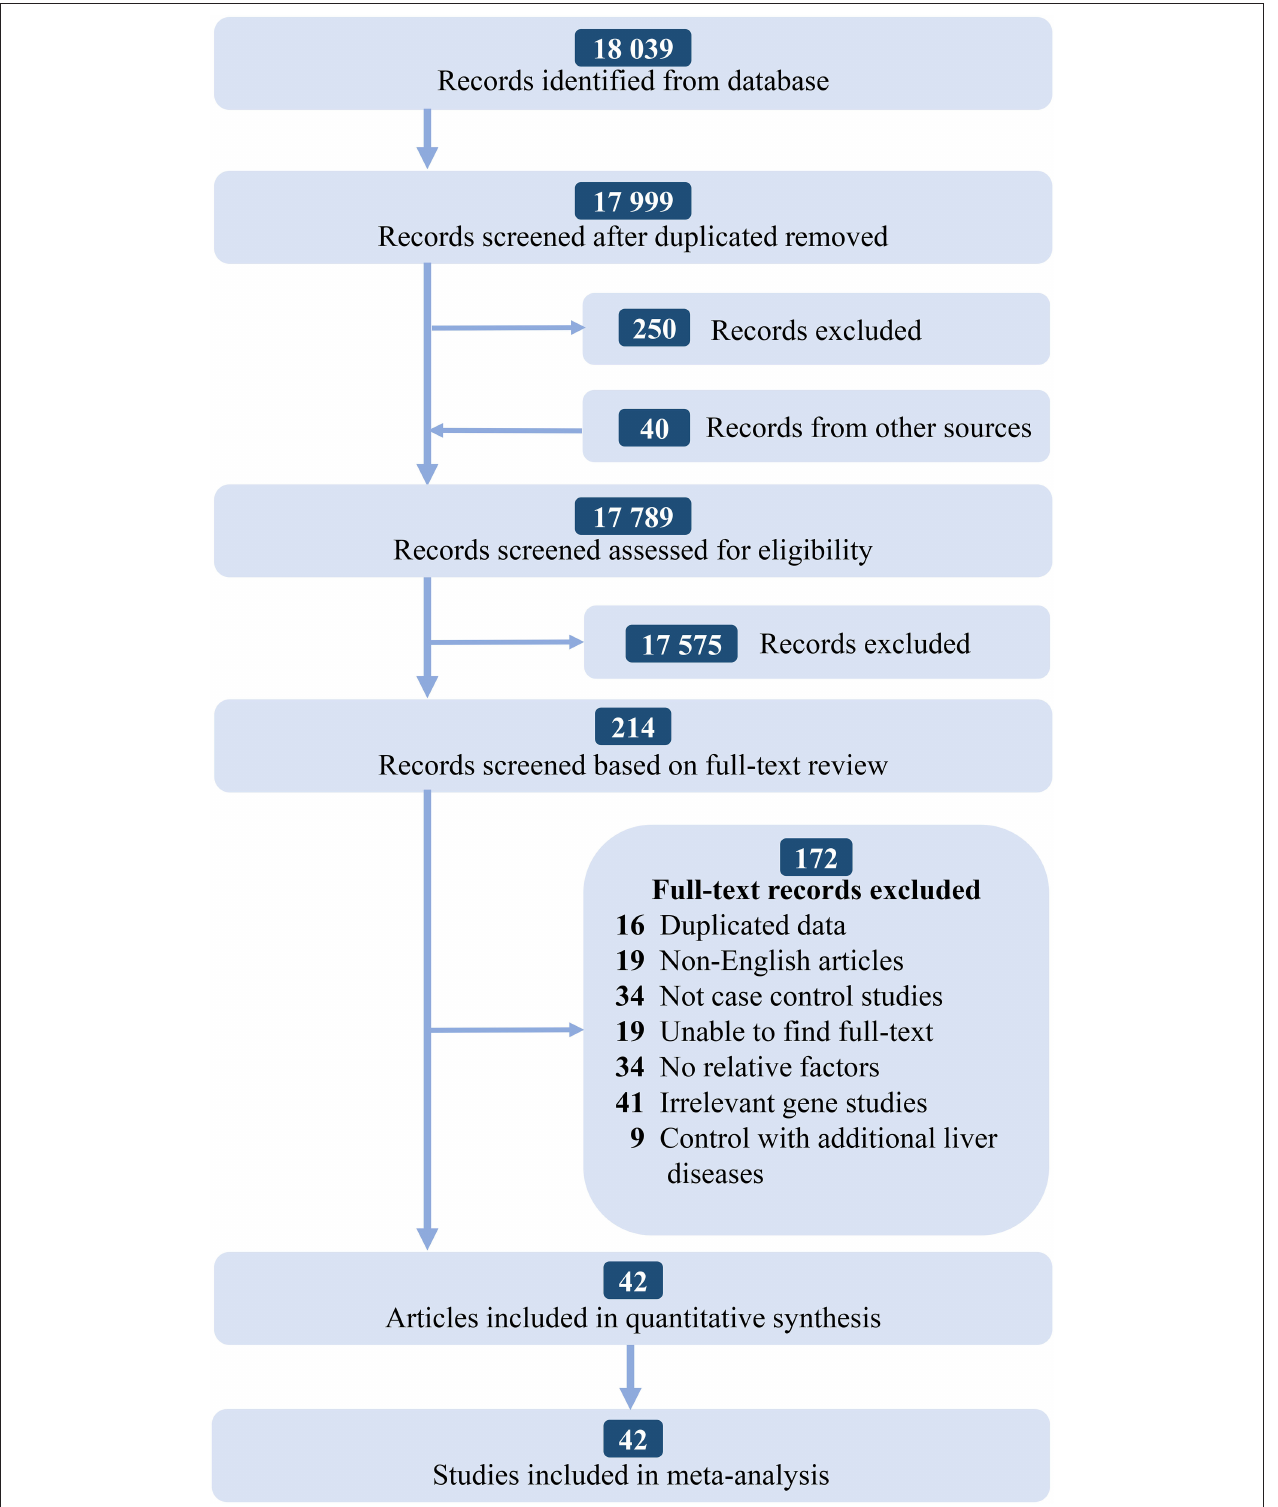
FIGURE 1 | Flowchart of the literature selection searching process and selection strategy.